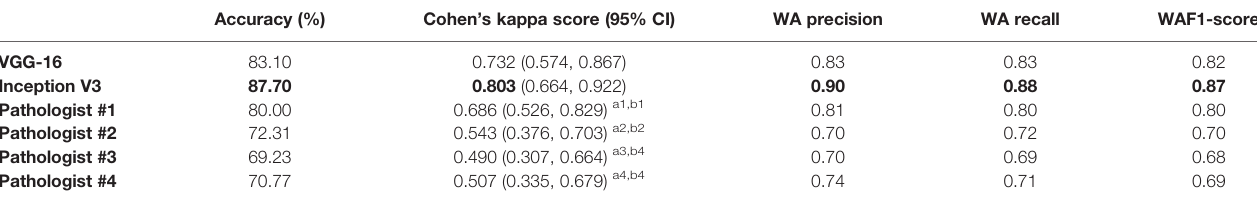
TABLE 4 | Performance of slide-level ternary classi fi cation on testing dataset.